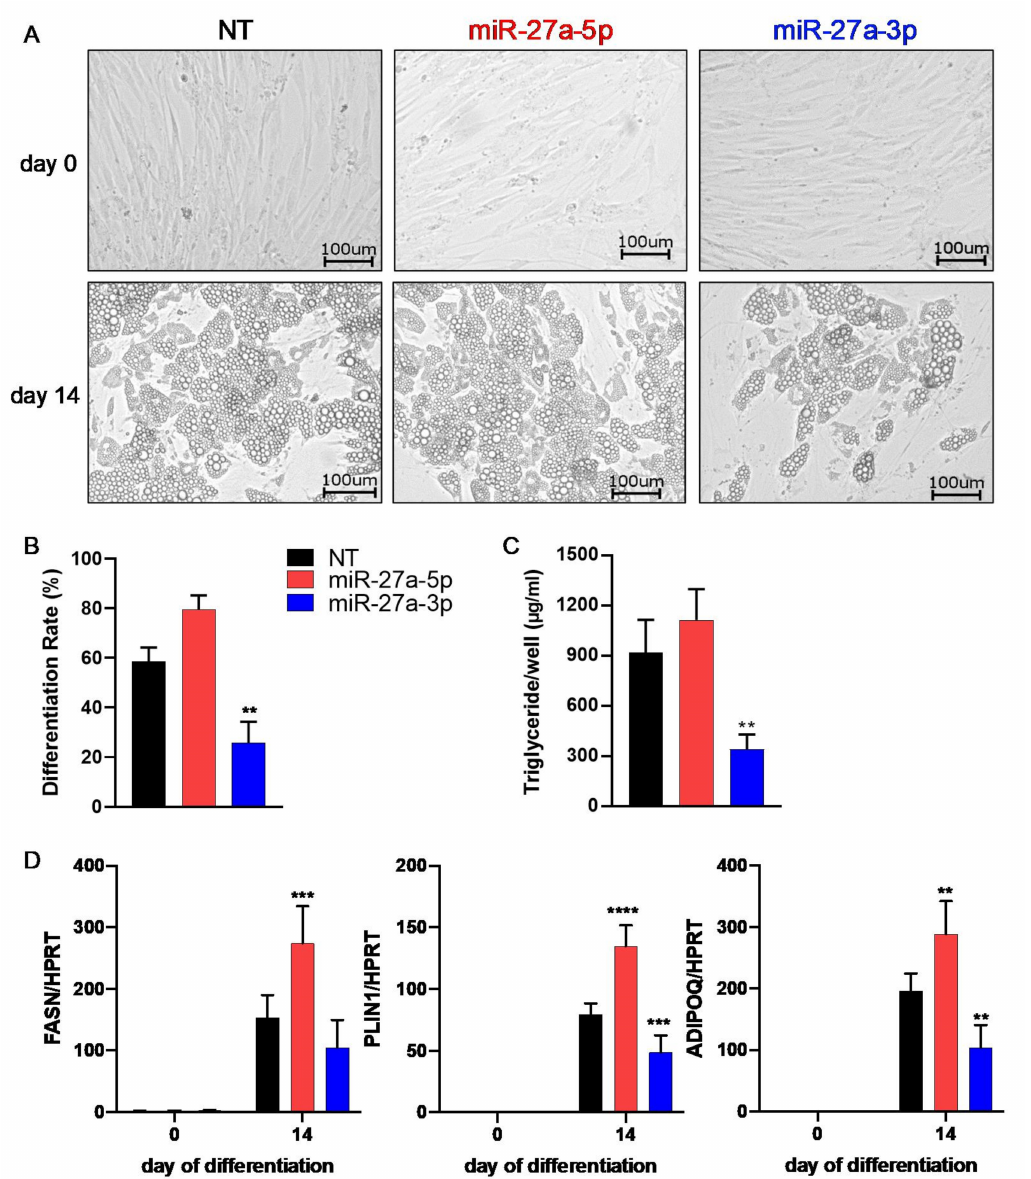
Figure 4. Adipogenic differentiation is inhibited by miR-27a-3p in hMADS cells. To assess the effect of miR-27a-5p and -3p on human multipotent adipose-derived stem cells (hMADS), preadipocytes were transfected 48 h prior to adipogenic induction with miRNA mimics or non-target control (NT, 20 nM). ( A ) Micrographs of transfected hMADS cells at indicated time points. ( B ) Differentiation rate and ( C ) triglyceride content on day 14. ( D ) mRNA expression of adipogenic markers as quantified by qPCR normalized to HPRT. Statistics: results are displayed as means and SEMs of 5 ( B , D ) or 3 ( C ) independent experiments. One-way ( B ) and two-way ANOVA ( C ) with Dunnett’s correction with respect to NT of the same time point; ** p < 0.01; *** p < 0.001; **** p < 0.0001. HPRT: hypoxanthine-guanine phosphoribosyltransferase; FASN: fatty-acid synthase; PLIN1: perilipin; ADIPOQ: